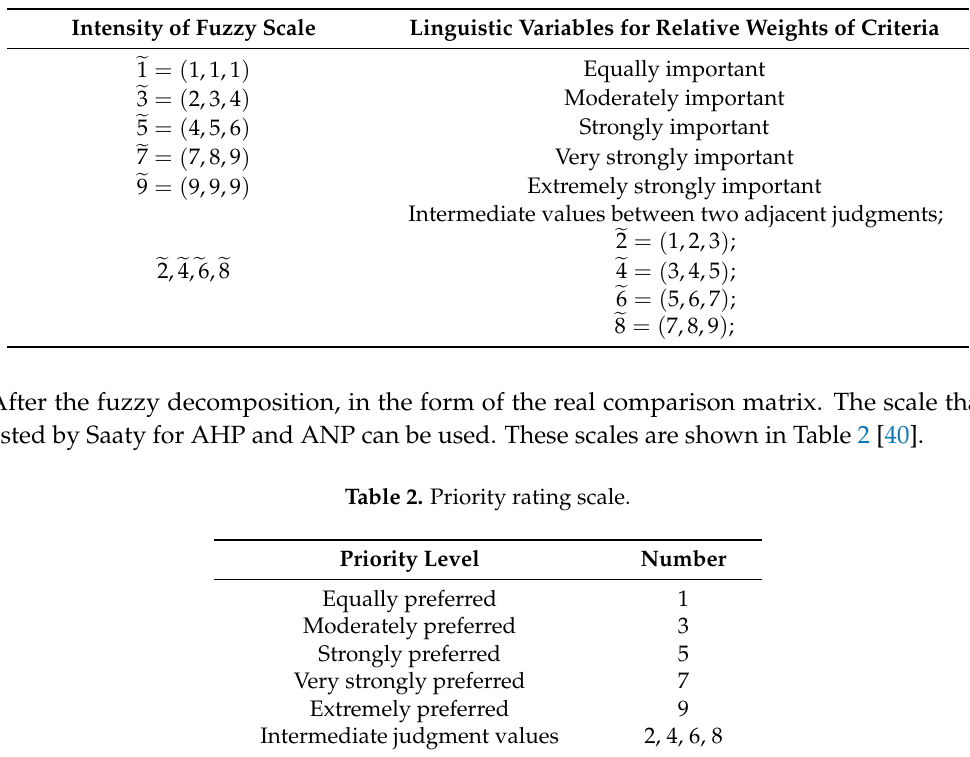
Table 1. Fuzzy conversion scale [39].